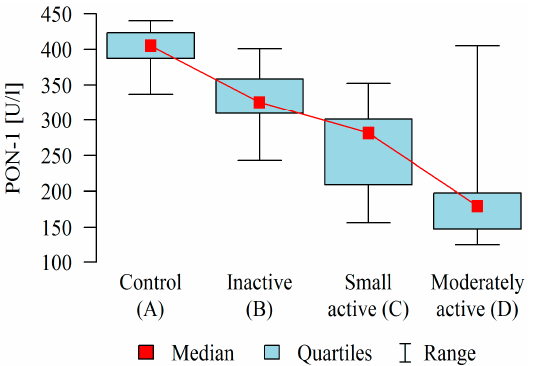
Figure 1. Activity of paraoxonase-1 (PON-1) in the blood plasma of patients in different stages of Crohn’s disease compared to control.